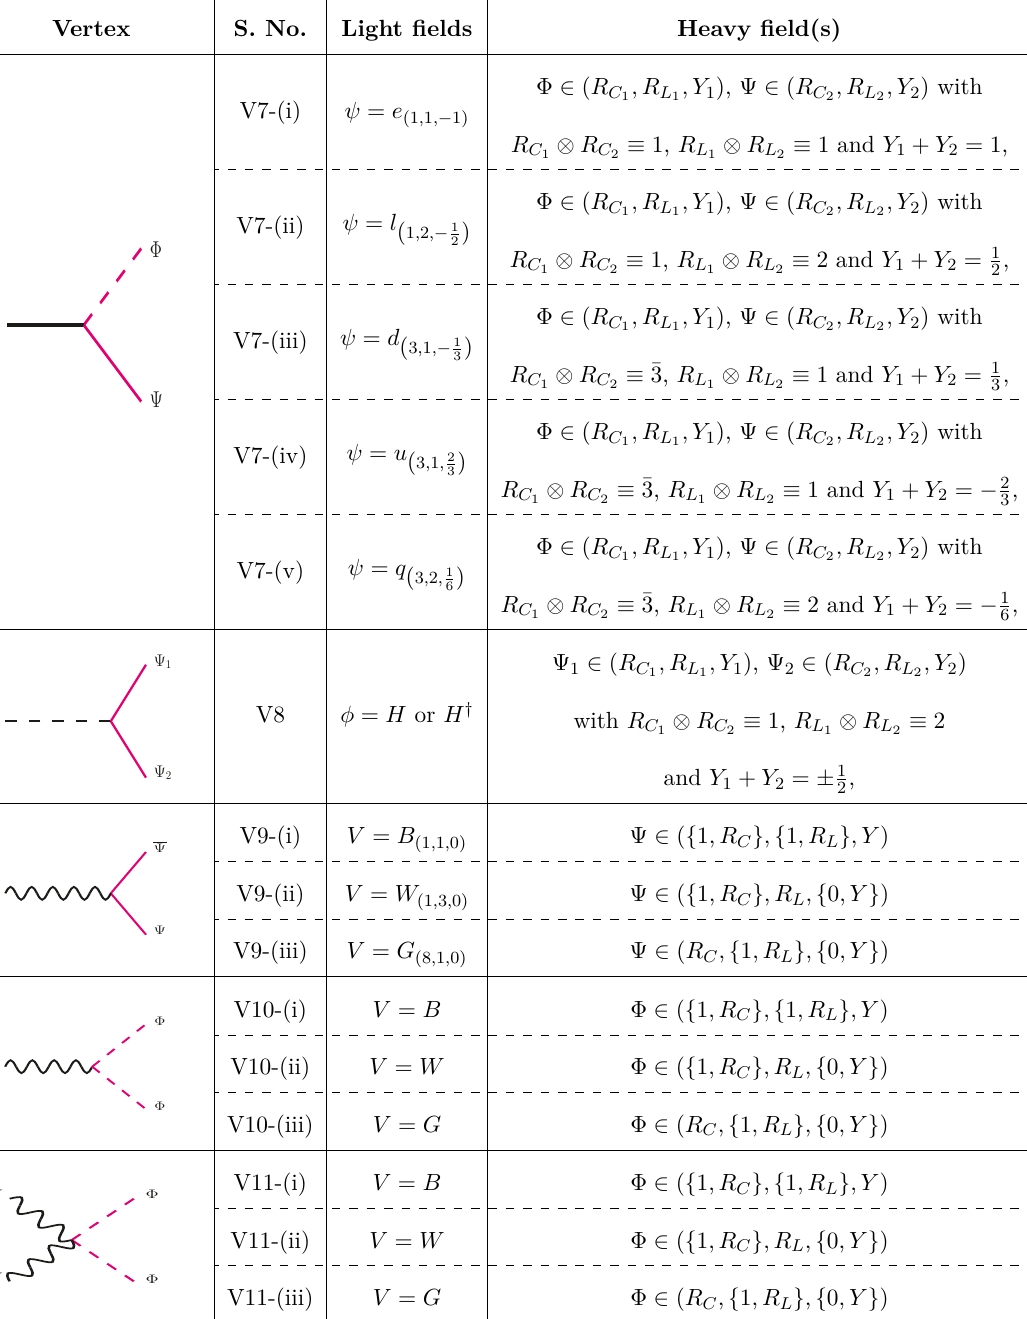
Table 4 . Table 3 continued. Here, φ i , ψ i and V denote the SM Higgs, the SM fermions and the SM gauge bosons respectively, whereas Φ and Ψ denote the various heavy scalars and heavy fermions. i i R C and R L denote SU(3) C and SU(2) L quantum numbers respectively and Y refers to the U(1) Y hypercharge of the